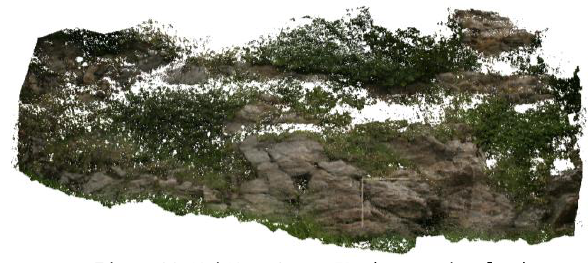
Figure 20. MicMac Canon5D dense point cloud